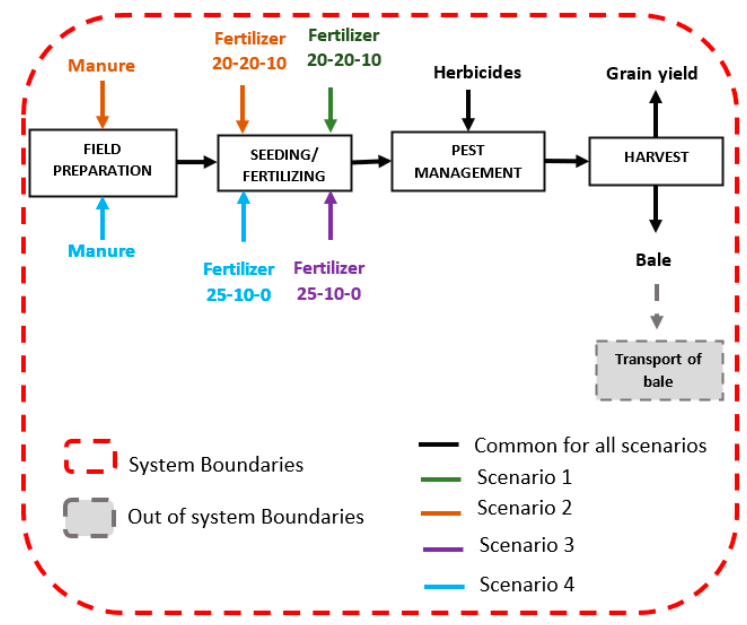
Figure 5. System boundaries along with the four scenarios investigated.